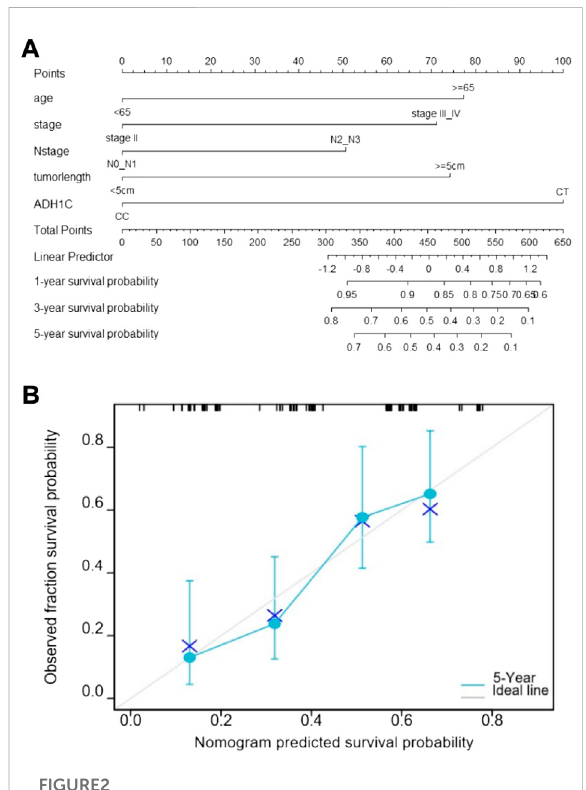
FIGURE2 Prediction nomogram for overall survival. (A) Nomogram